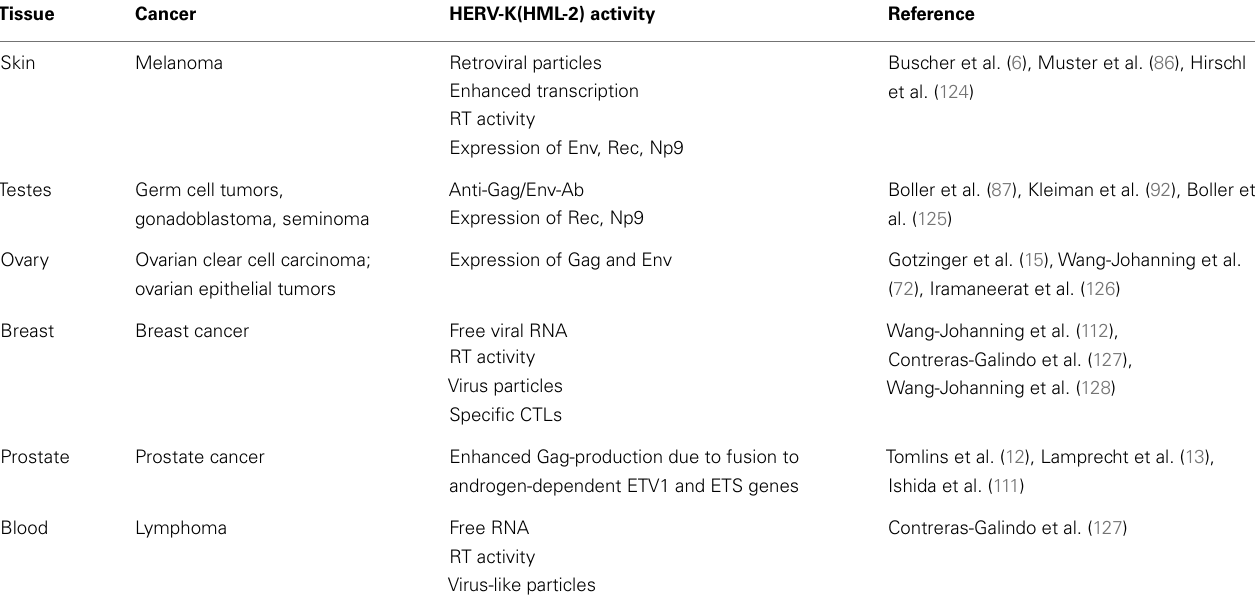
Table 2 | List of malignant diseases that are associated with HERV-K(HML-2)